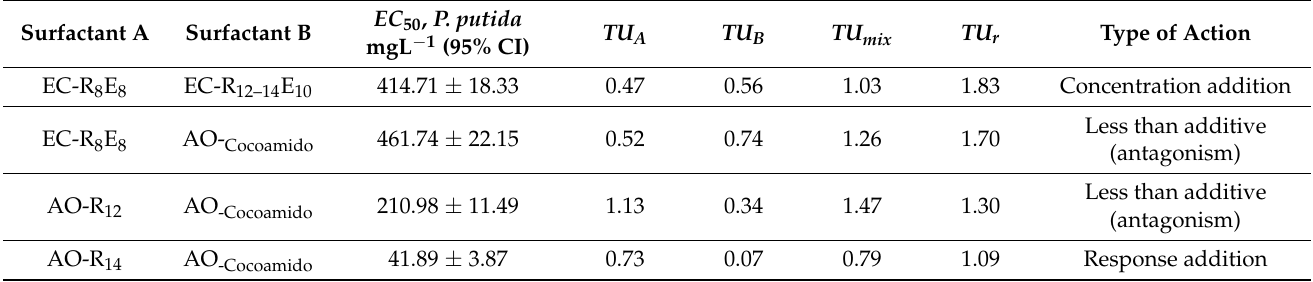
Table 5. Toxicity values and MTU parameters of surfactants mixtures (1:1 w / w ) to bacteria P. Putida (exposure time 16 h).